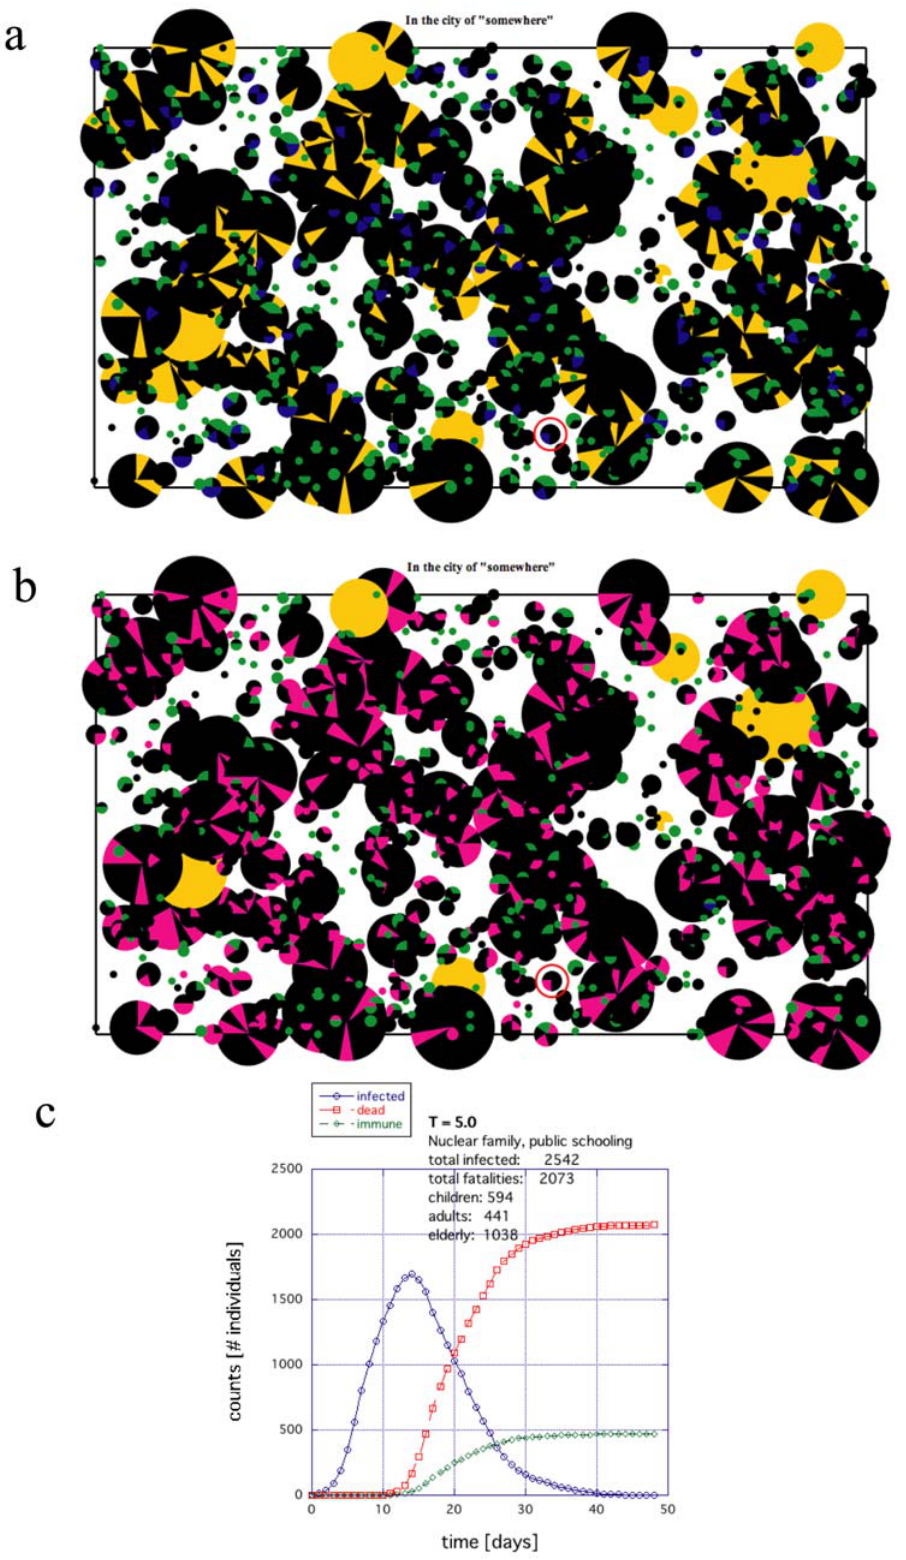
Figure 5. An example of the death toll for the nuclear family society where the E/R are placed together in large facilities and children are sent to public schools. The size of the circles indicates the relative population size. The black indicates those who have died. Yellow indicates E/Rs, blue indicates young, and green indicates adults. (a) Surviving population whether infected or not where black indicates deceased. (b) Population of infected individuals both deceased (black) and recovered (magenta). (c) Time histogram of the rate of infection, death and recovery.